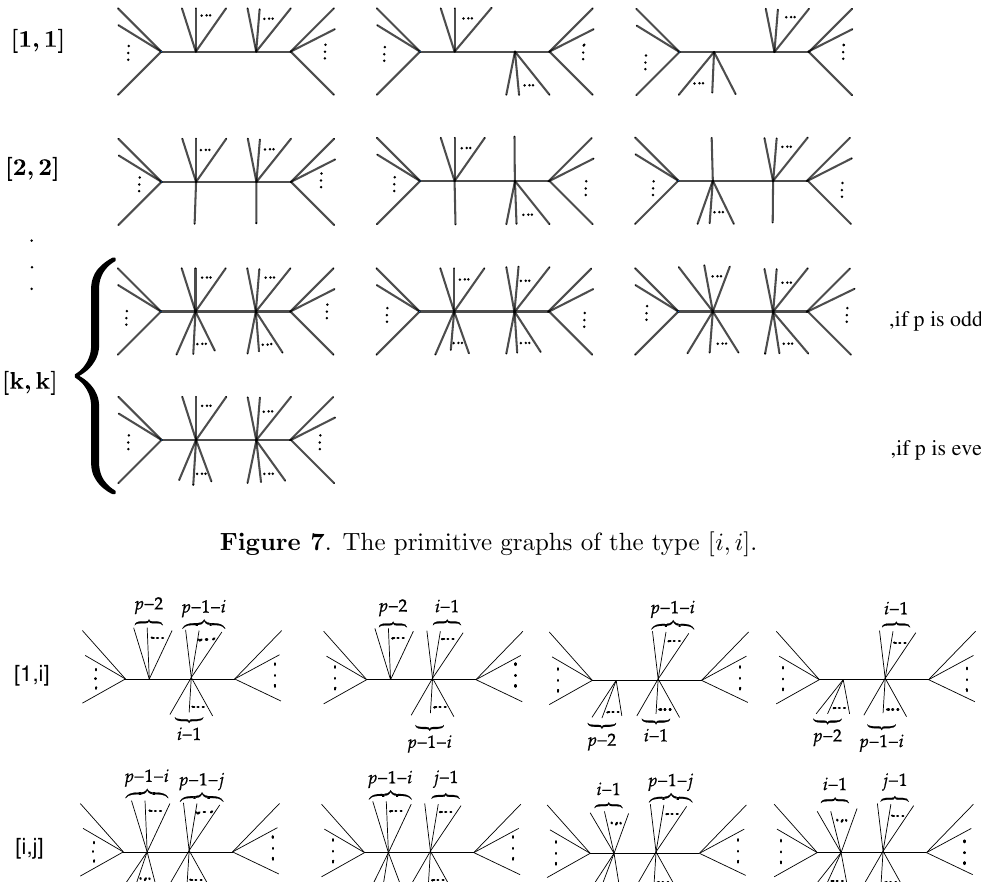
Figure 8 . The primitive graphs of the type [ i; j